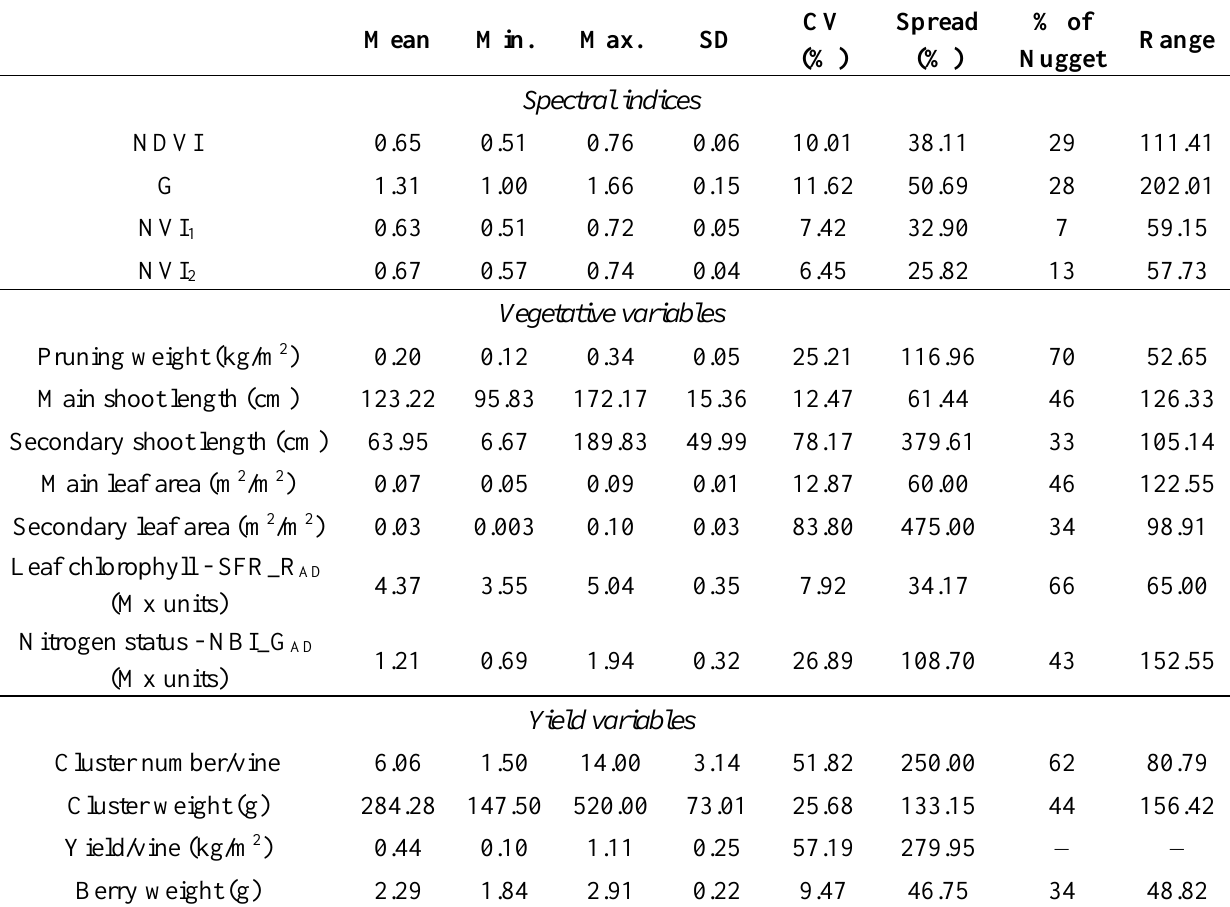
Table 2. Descriptive statistics and variogram components for spectral indices (NDVI, G, NVI 1 , and NVI 2 ), vegetative parameters (pruning weight, main shoot length, secondary shoot length, main leaf area per shoot, and secondary leaf area per shoot), fluorescence-based indices of nitrogen balance index (NBI_G AD ), and chlorophyll content in leaves (SFR_R AD ) for yield parameters (cluster number per vine, cluster weight, yield per vine, and berry weight) and for grape composition variables (pH, total soluble solids, titratable acidity, anthocyanins, and total phenols) in a Tempranillo ( Vitis vinifera L.)